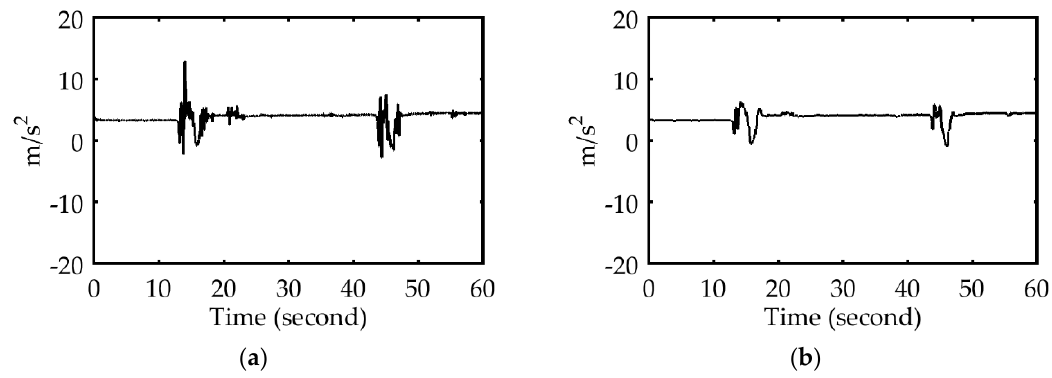
Figure 4. ( a ) X-axis accelerometer signal with noise. ( b ) Median filtered X-axis accelerometer signal. In the simulated environment, the threshold value of the steering wheel angle for partitioning the signal was set to ± 30 ◦ . Figure 5a displays the correlation between the accelerometer and the steering wheel signals at different periods. By contrast, the threshold value of the angular velocity of the smartphone’s gyroscope for partitioning the signal was set to ± 10 ◦ /s. Figure 5b displays the correlation between the accelerometer and the gyroscope of the smartphone at different